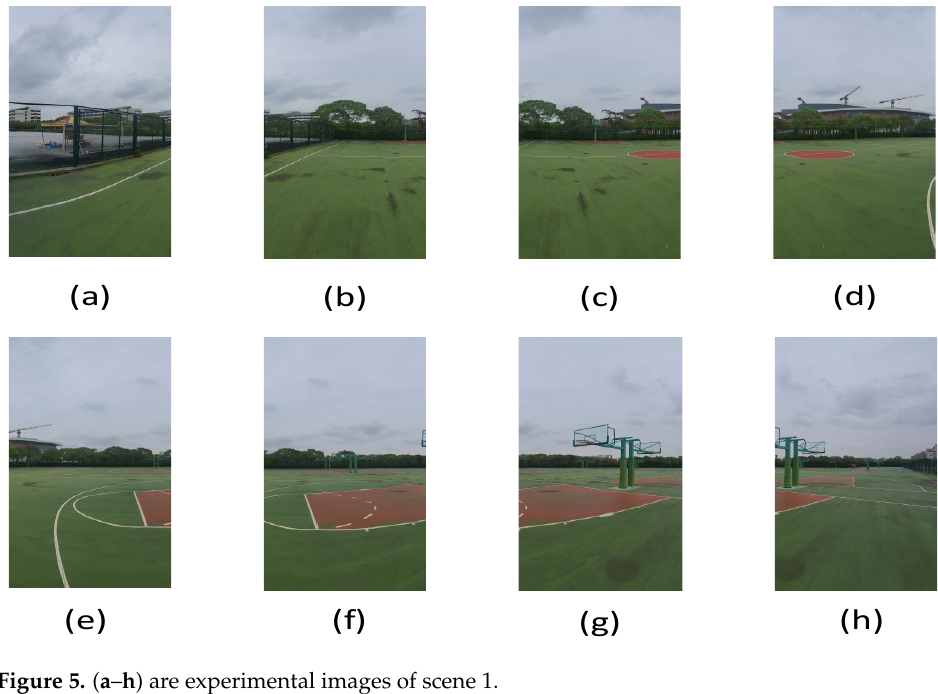
Figure 5. ( a – h ) are experimental images of scene 1.